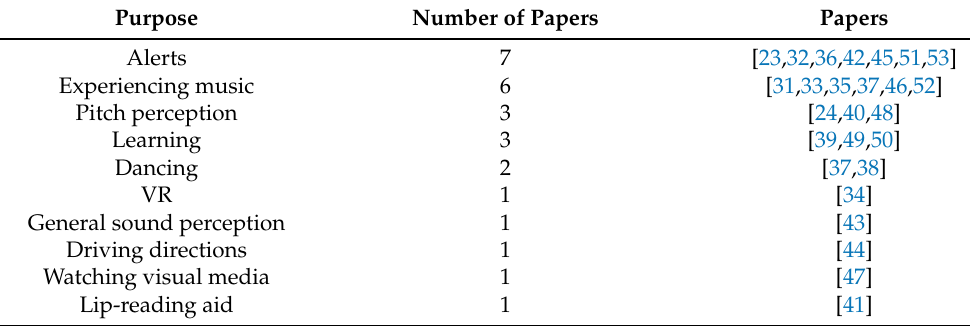
Table 5. Papers grouped by the general purpose of the device. Purpose Number of